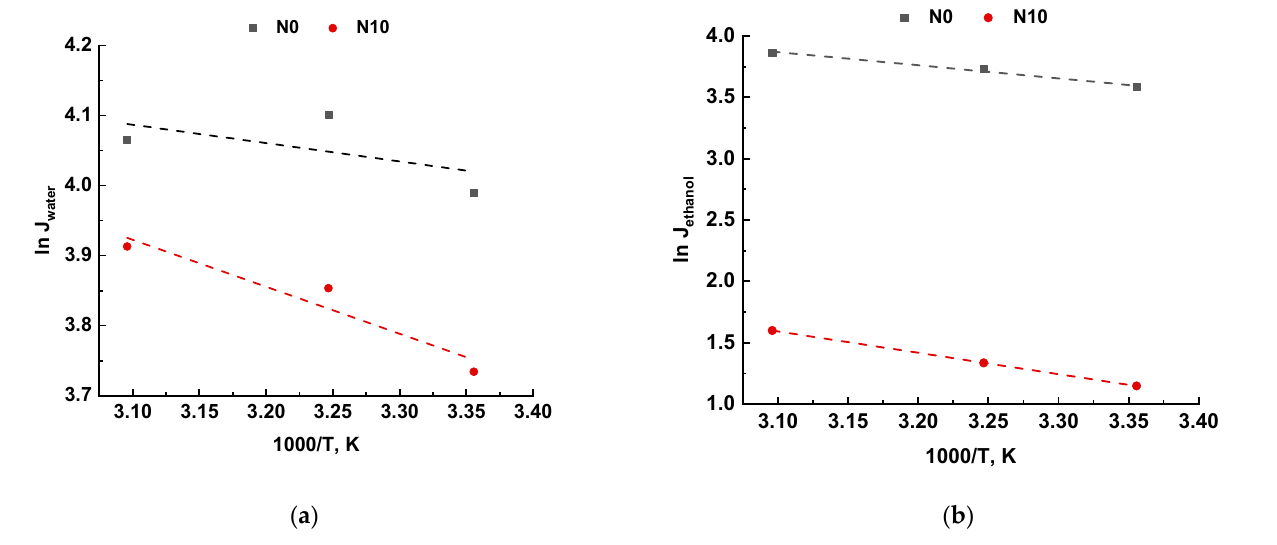
Figure 8. The dependence of natural logarithm of the partial water ( a ) and ethanol ( b ) fluxes on the temperature according to Arrhenius plot in pervaporation of 90 wt.% ethanol/10 wt.% water mixture. The values of apparent activation energy for N0 and N10 membranes are presented in Table 4. Table 4. The apparent activation energy of N0 and TFN N10 membranes.